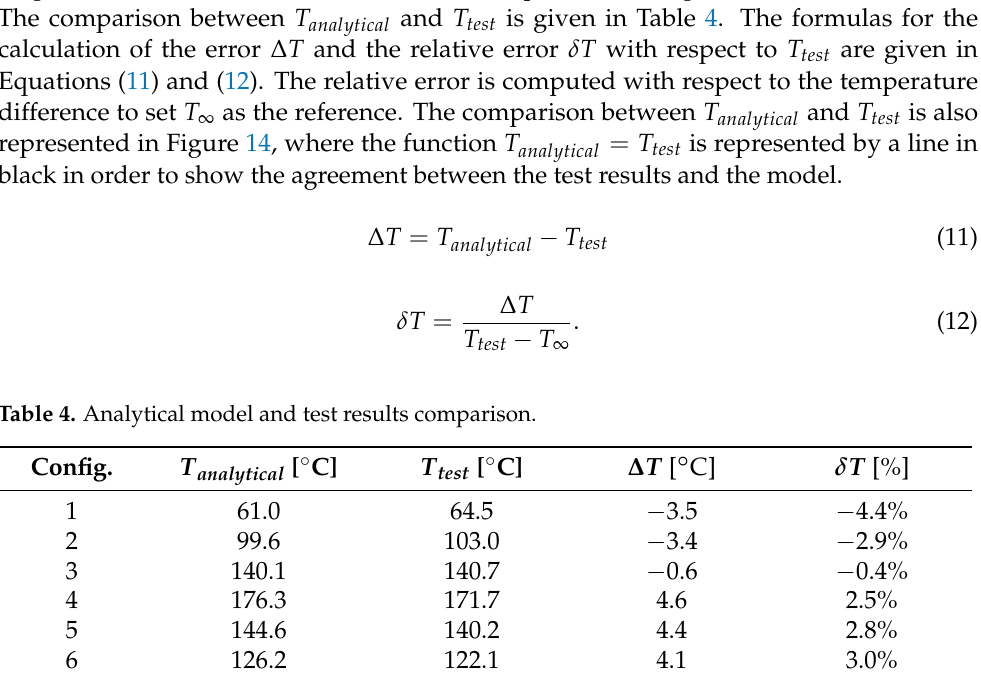
Figure 13. Considered probe length by the analytical model and neighboring measurement points.